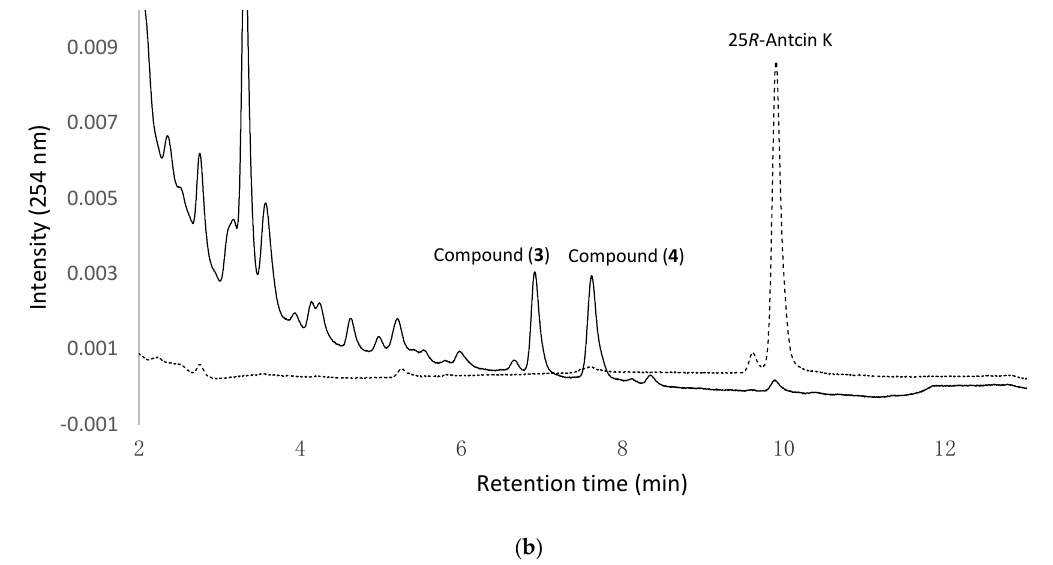
Figure 1. Biotransformation of antcin K by B. subtilis ATCC 6633. The strain was cultivated in modified glucose nutrient (MGN) media containing ( a ) 25 S -antcin K or ( b ) 25 R -antcin K. The initial (dashed curves) and 24 h (solid curves) cultivations of the fermentation broths were analyzed with an UPLC system equipped with an Acquity ® UPLC BEH C18 column (Acquity UPLC BEH C18, 1.7 μm, 2.1 i.d. × 100 mm, Waters, Milford, MA, USA). The UPLC operation conditions are described in Materials and Methods.